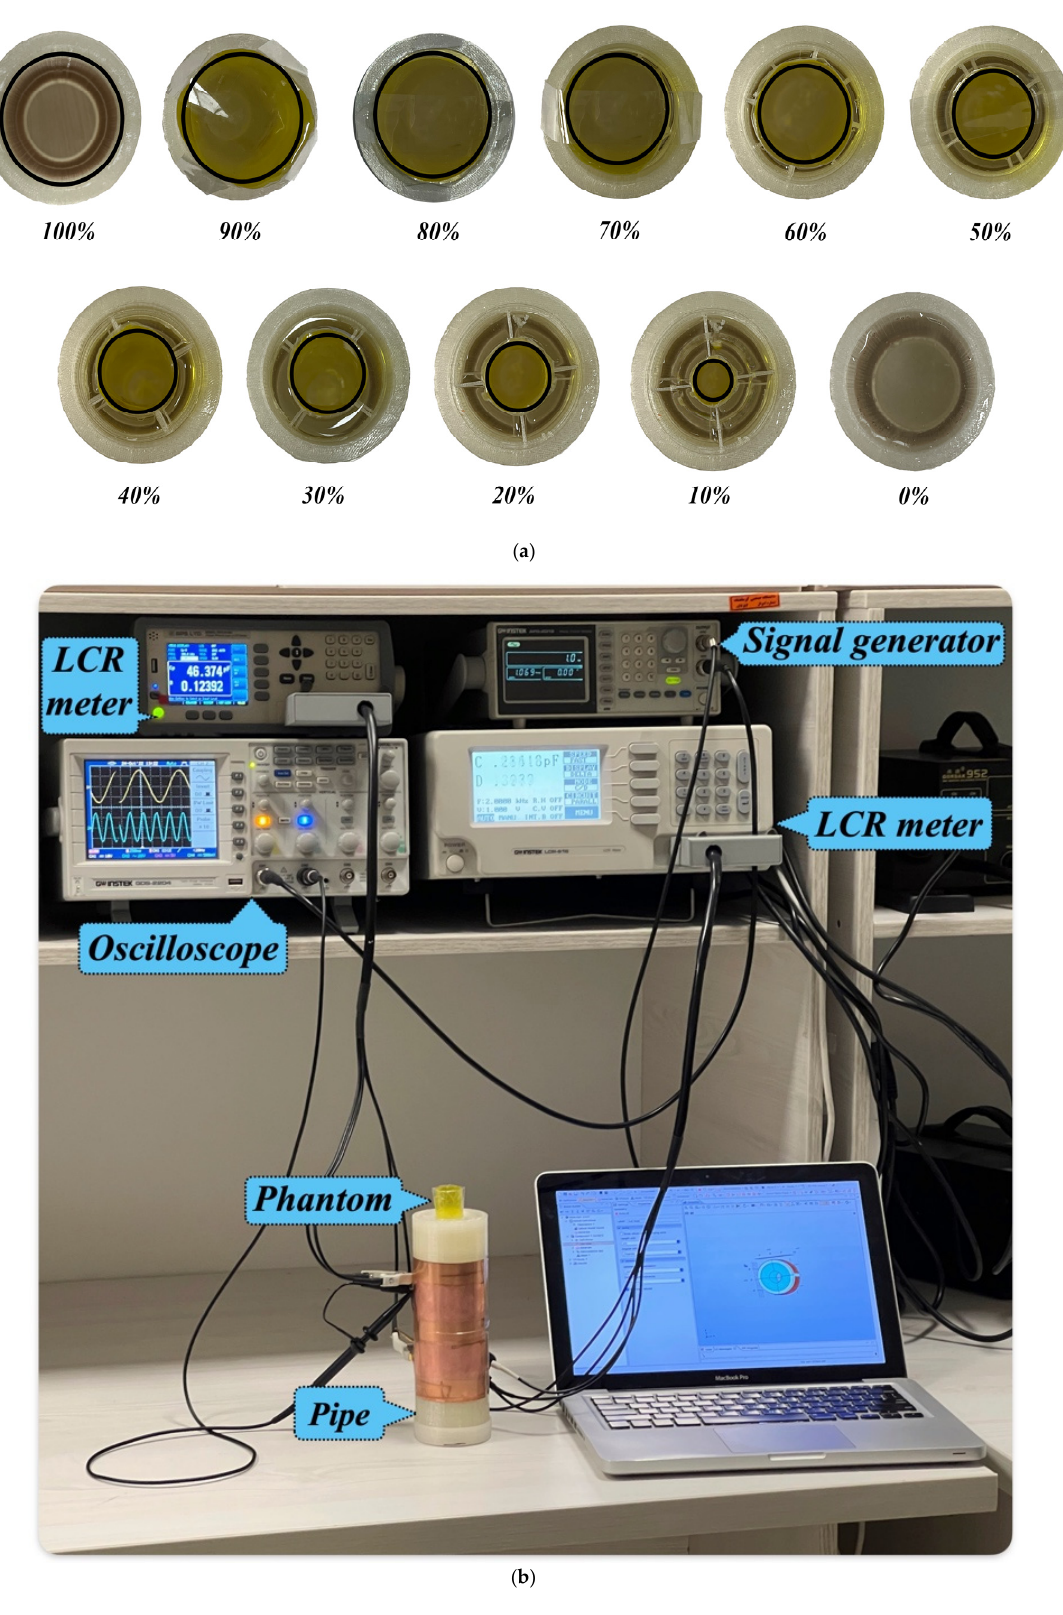
Figure 6. ( a ) Different void fractions generated by the phantoms. ( b ) Experimental setup. Table 1. Measured results by the experimental setup for the concave sensor in the annular water– air regime.